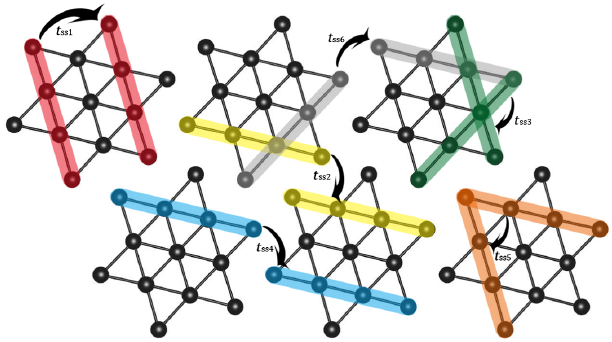
FIG. 7. Physical meaning of the hopping parameters between the surrounding orbitals listed in Table